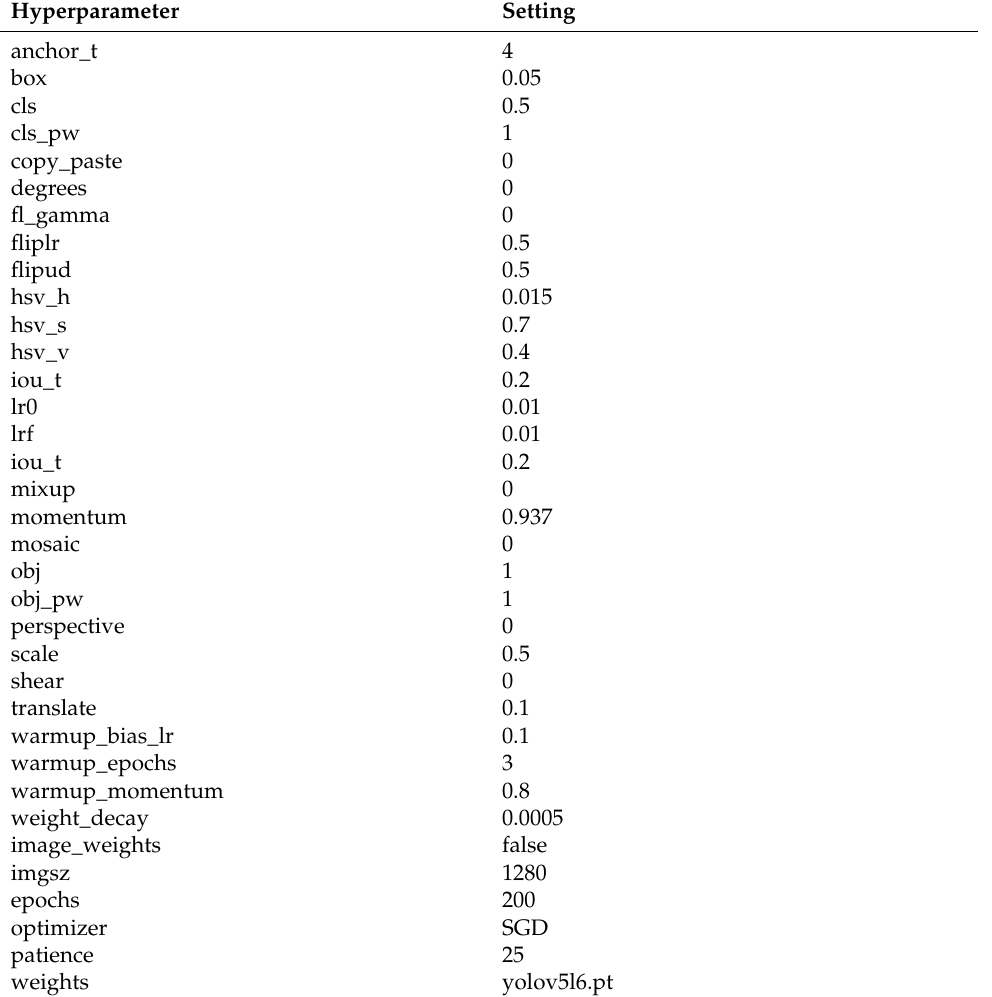
Table A1. Hyperparameter settings used for the Training of